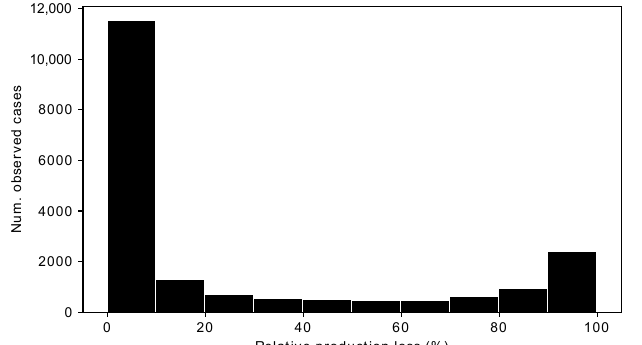
Figure 2. Frequency of observed relative production losses, including all stations and periods.